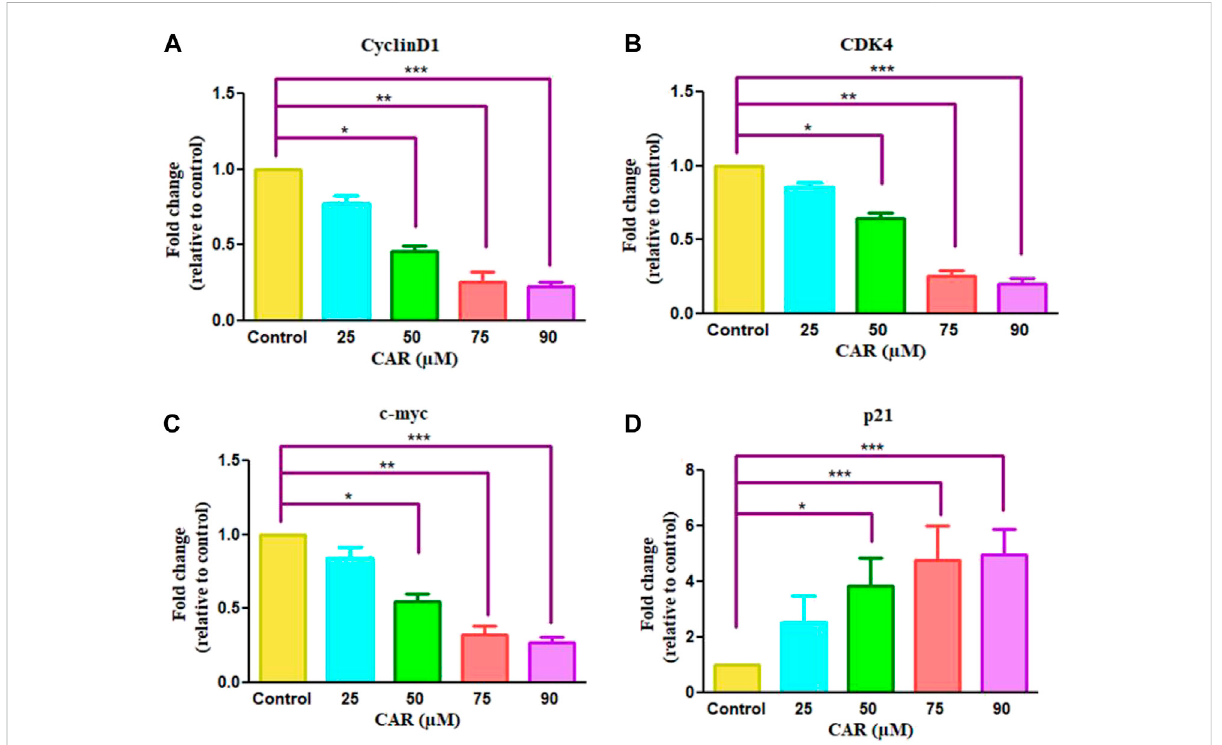
FIGURE 7 Effect of CAR on the mRNA expression of cell cycle regulatory genes in C33A cells. Fold change in the mRNA expression of antiapoptotic proteins and pro-apoptotic proteins such as (A) cyclinD1 (B) CDK4 (C) c-myc and (D) p21genes were analyzed by real-time PCR using SYBR Green dye.Target gene expression isnormalized toGAPDHmRNA expression andtheresults areexpressedasfold changefrom control.Data reported are mean ± SEM of three separate experiments each of which were performed in triplicates. Signi fi cant difference among the treatment groups were analyzed by two tailed Paired Student ’ s t-test and one-way ANOVA followed by Dunnett post hoc test (* p < 0.05 , ** p < 0.01 , *** p < 0.001 represent signi fi cant difference compared with control).